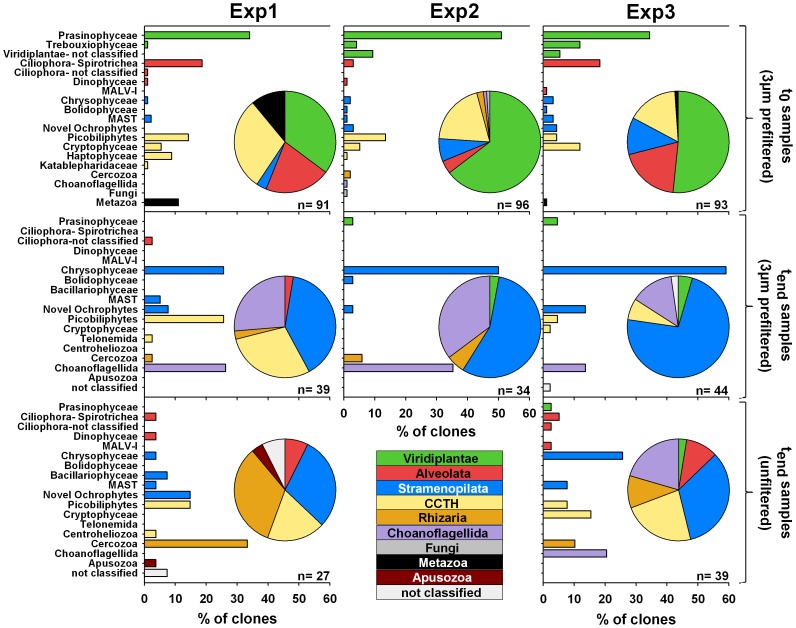
Phylogenetic composition in clone libraries constructed from the three incubation experiments.Upper and middle panels show the composition of clones in the 3-µm filtered initial and final incubation samples, respectively. The unfiltered final incubation samples are represented by the lower panels. For each library, the proportion of clones within the major taxonomic groups is displayed as pie charts. A finer resolution of the taxonomic groups and their contribution to each library is shown in the bar charts.